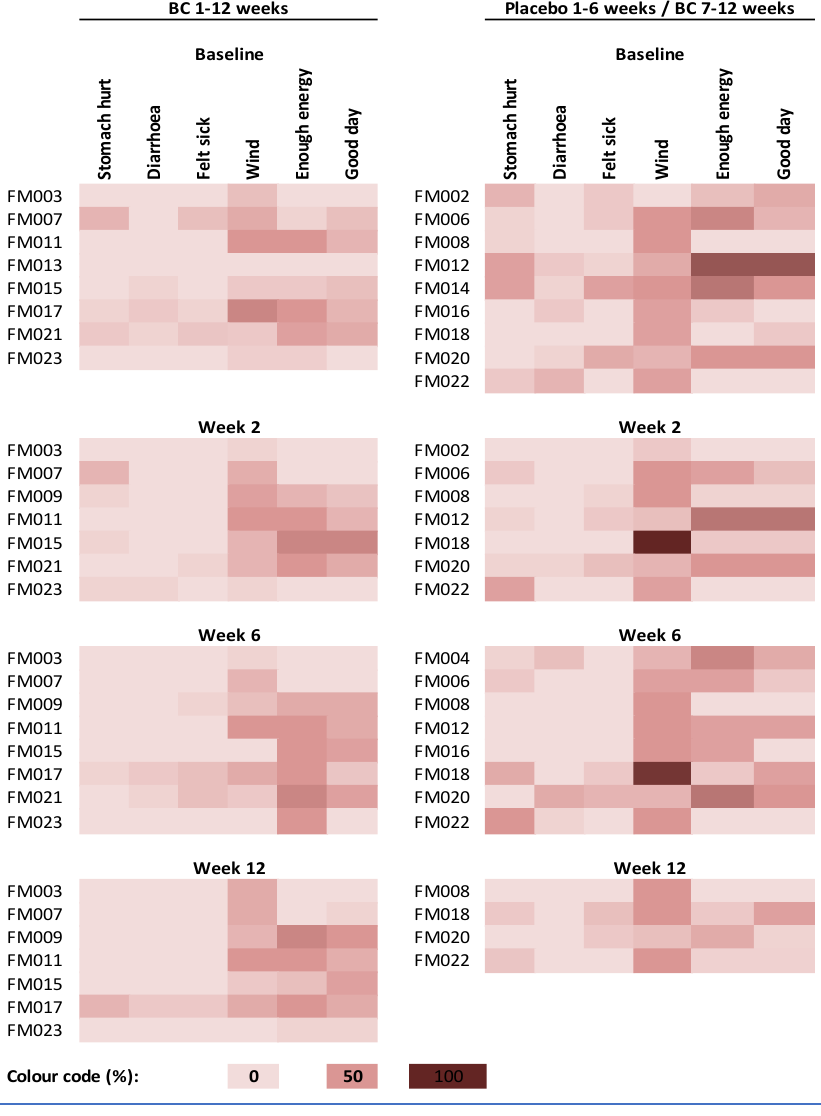
Figure 2. Average 7-day symptom and well-being scores for individual participants. Colour scale ranges from 0% (an absence of all four symptoms, lots of energy and had a good day on every day of the week) to 100% (the highest symptom score, no energy and an awful day on every day of the week).